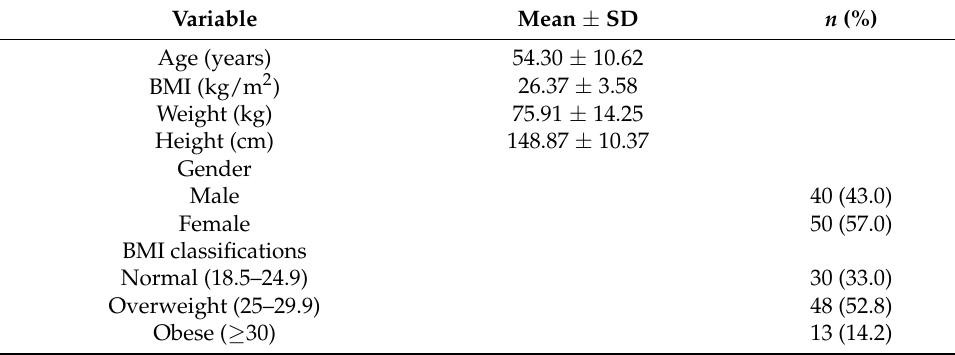
Table 1. Baseline characteristics of study